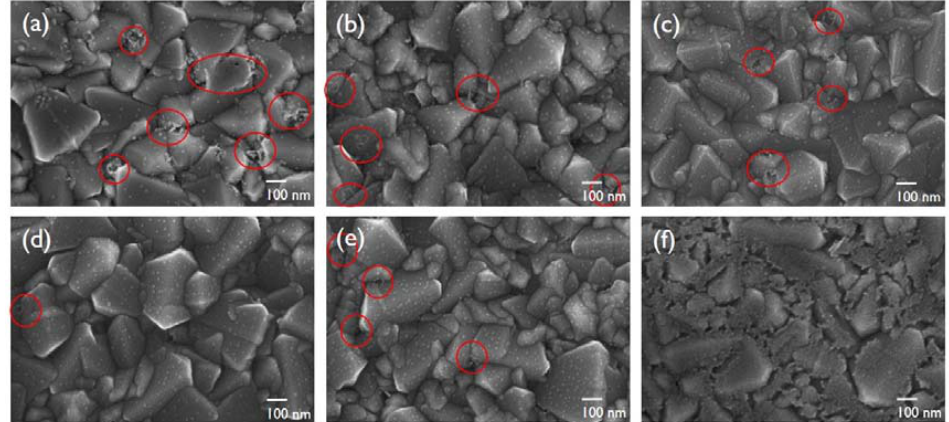
Figure 2. Field ‐ emission scanning electron microscope (FE ‐ SEM) images of Pt films on FTO substrates: Figure 2. Field-emission scanning electron microscope (FE-SEM) images of Pt films on FTO substrates: ( a ) PR ‐ 130, ( b ) PR ‐ 150, ( c ) PR ‐ 170, ( d ) PR ‐ 190, ( e ) PR ‐ 210, and ( f ) TD ‐ 425. ( a ) PR-130, ( b ) PR-150, ( c ) PR-170, ( d ) PR-190, ( e ) PR-210, and ( f ) TD-425.